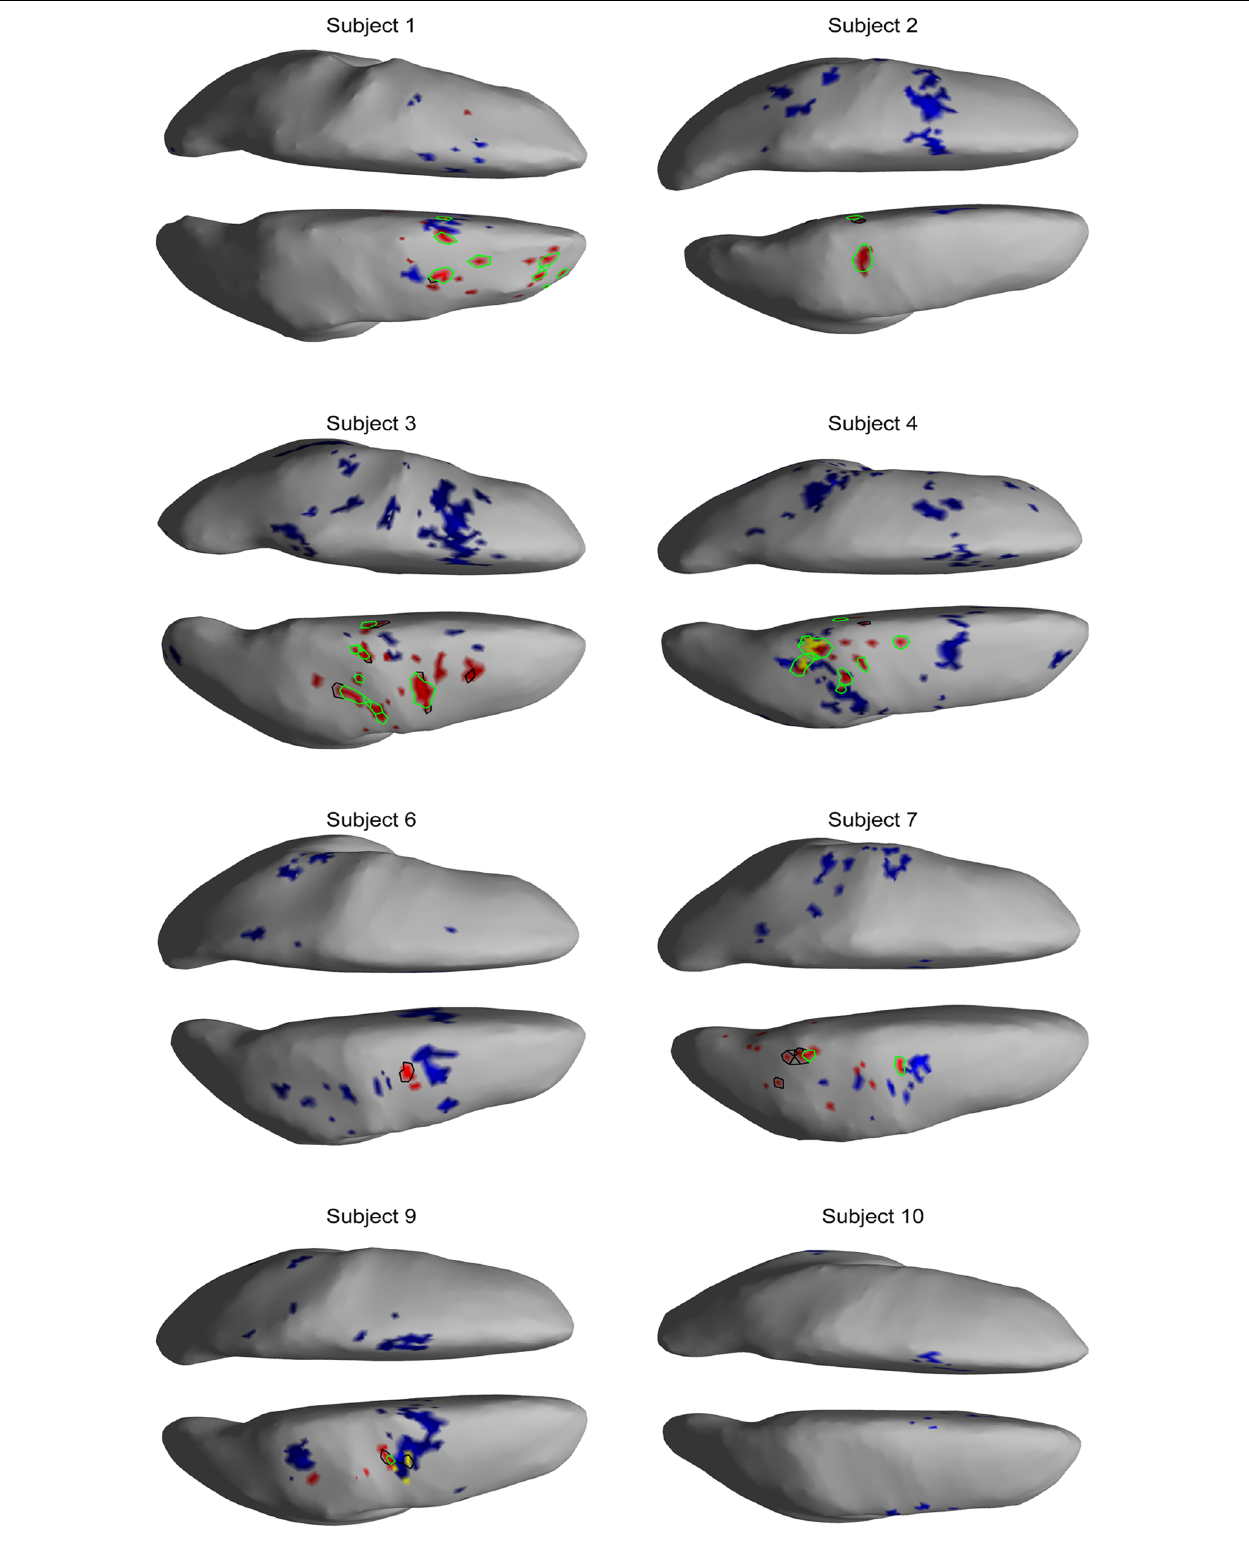
FIGURE 7 | EEG and fMRI BOLD activity mapped to realistic cortical headmodels of 7 of the remaining subjects during left hand motor imagery.